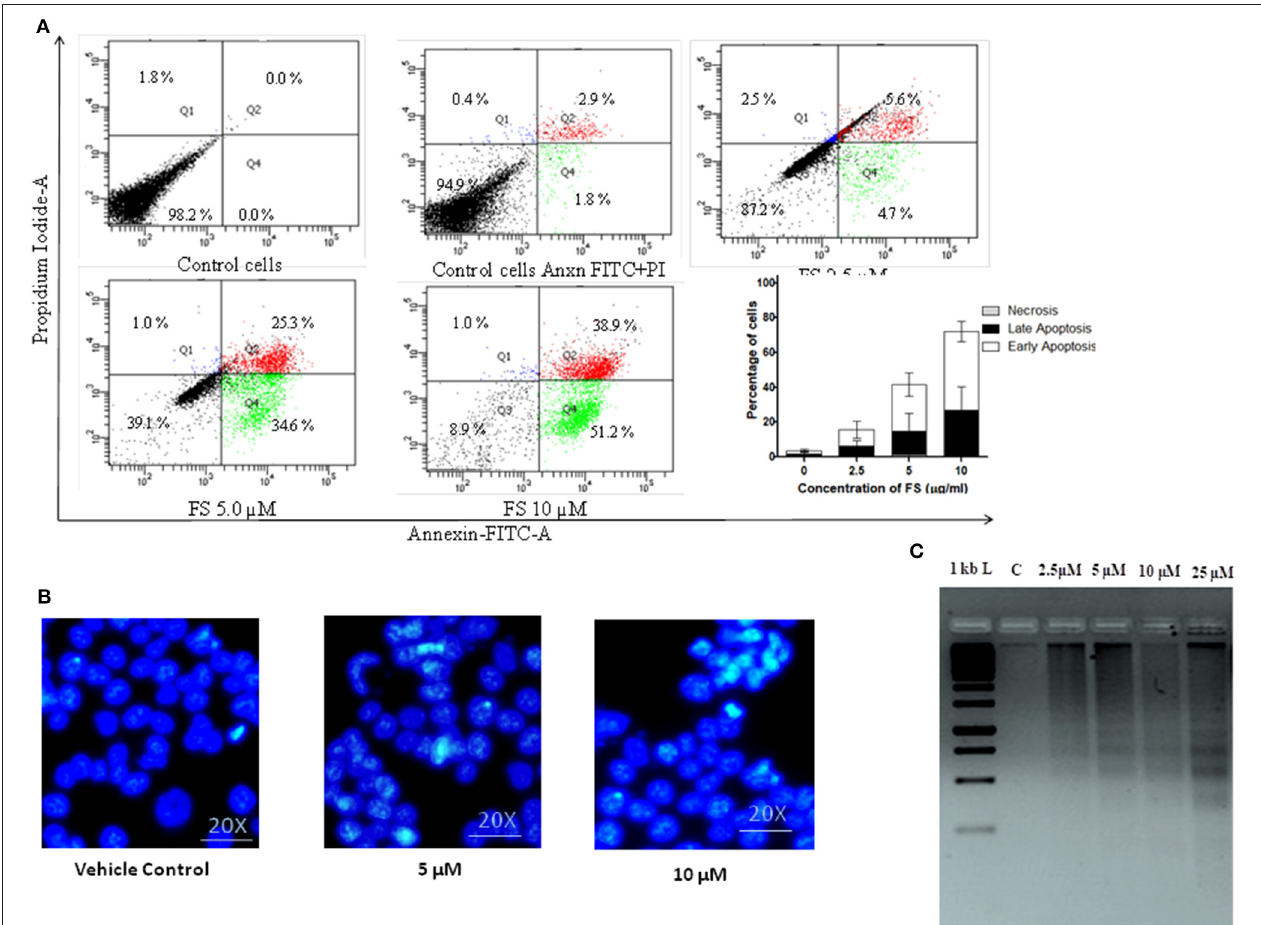
FIGURE 3 | Fungal taxol (FS)-induced apoptosis in A549 cells. (A) Effect of FS treatment on phosphatidyl serine on plasma membrane externalization. The cells were treated with an indicative concentration of FS for 24h, stained with annexin V–fluorescein isothiocyanate and propidium iodide (PI), and analyzed by flow cytometry. The live cells are both annexin V-negative and PI-negative (Q3—left lower quadrant), while the cells that are in early apoptosis are annexin V-positive and PI-negative (Q4—right lower quadrant), and the cells that are in late apoptosis or already dead are both annexin V-positive and PI-positive (Q2—right upper quadrant). The bar diagram represents the percentage of cells in the early and the late phases of apoptosis, respectively. Data are the means ± SD of three independent experiments. (B) Morphological changes of FS-treated A549 cells stained by DAPI. The cells were subjected to a 12-h treatment with FS. The occurrence of nuclear shrinkage was accompanied by chromatin condensation (indicated by arrows) in the cells. DMSO-treated (0.1%) cells served as vehicle control. (C) Effect of FS on DNA fragmentation assay in A549 cells. The cells were treated with indicated concentrations of FS for 24h. M, DNA molecular size marker. DNA was extracted, and fragmentation was determined by agarose gel electrophoresis. The gel stained with ethidium bromide was viewed under a UV